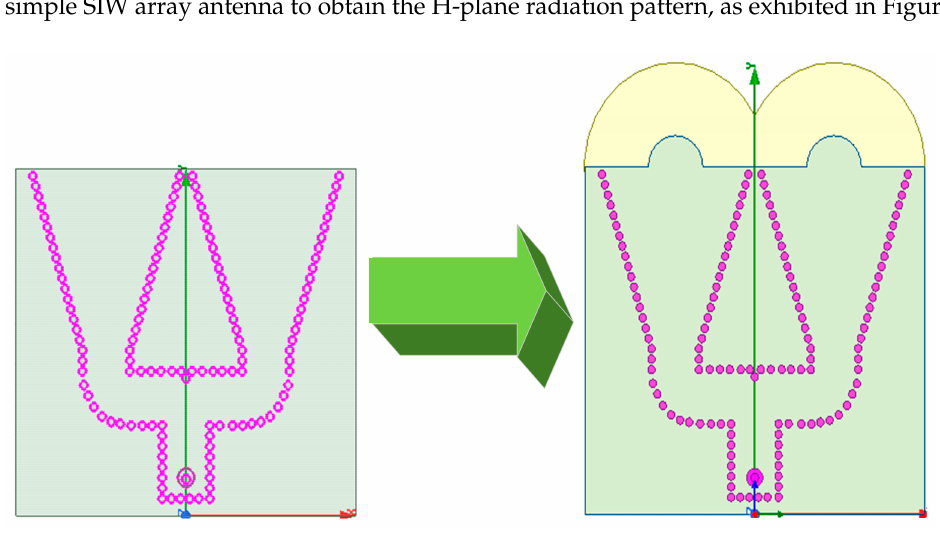
Figure 9. Comparison of antenna structure before and after improvement.